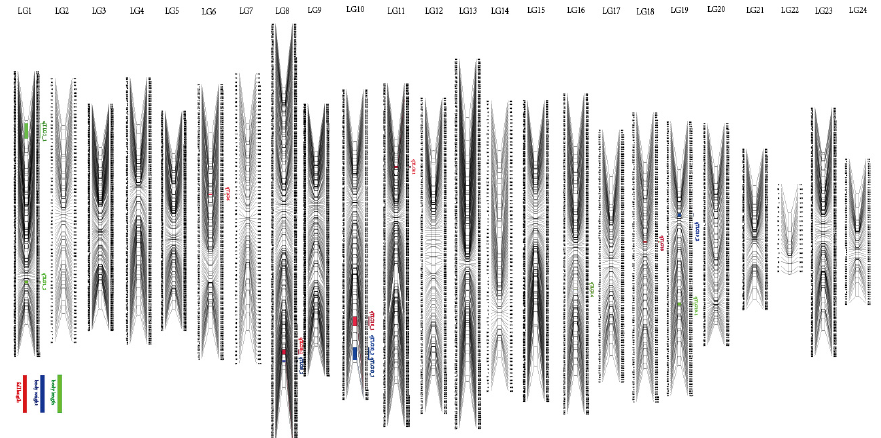
Figure 1. LG lengths and marker distributions of a high-resolution genetic map of the red-spotted grouper. Quantitative trait loci (QTL) names are shown on the left side of each LG. Red, green, and blue represent the full length, body length, and body weight traits, respectively.